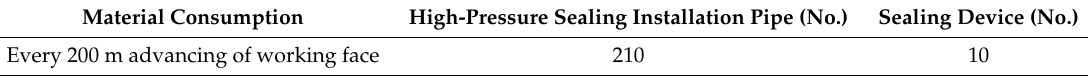
Table 3. Materials consumption of hydraulic fracturing combining pre-pulse and constant pumping